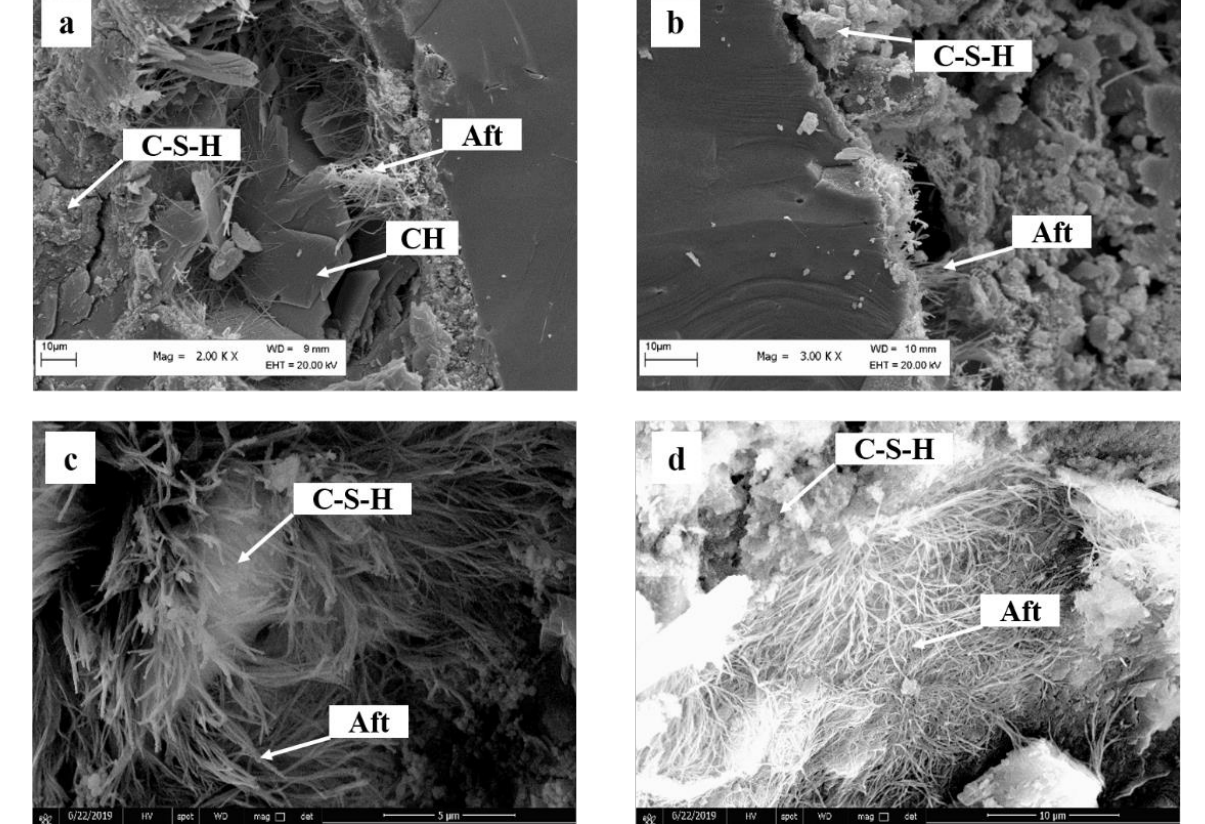
Figure 5. Microstructure of ( a ) cement, ( b ) cement with CA, ( c ) cement with TEA and ( d ) cement with CC.